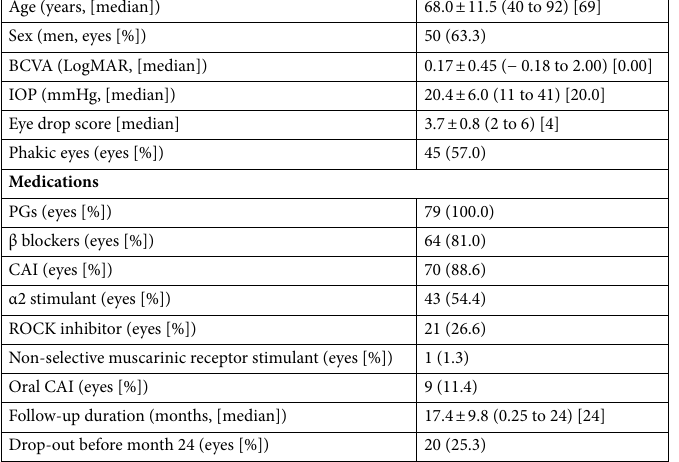
Table 1. Baseline characteristics. Dara are shown in mean ± standard deviation (SD) and median. BCVA best- corrected visual acuity, IOP intraocular pressure, PGs prostaglandin-related ophthalmic solutions, β blockers β adrenergic antagonists, CAI carbonic anhydrase inhibitors, α2 stimulant α2 selective adrenergic agonists, ROCK inhibitor Rho kinase